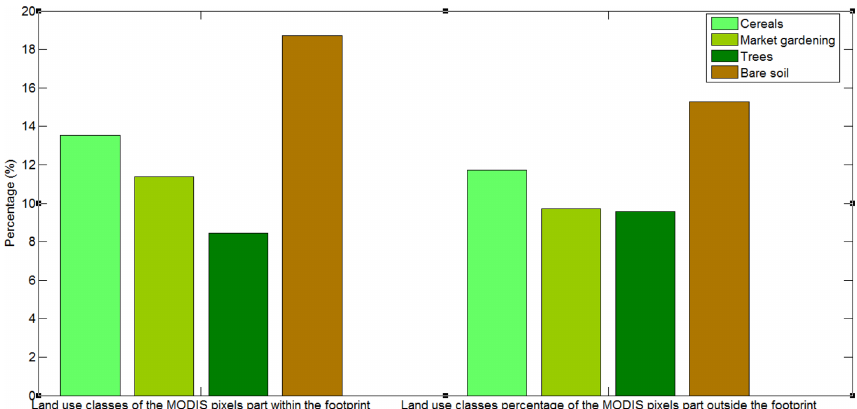
Figure 4. Land use classes’ percentage of the MODIS pixels within or outside the